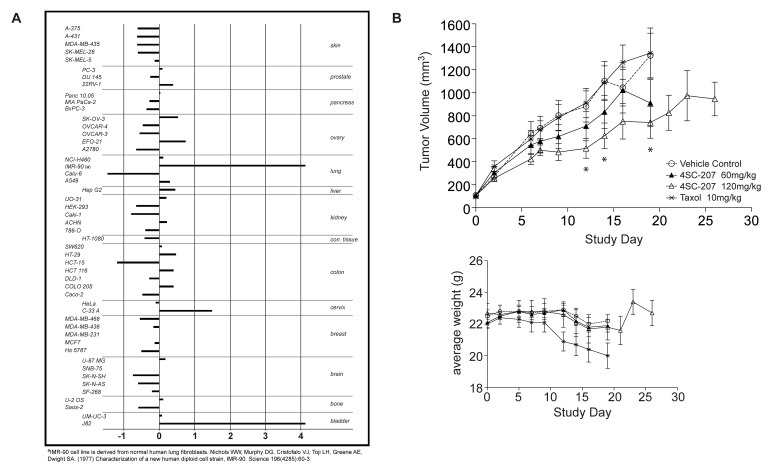
4SC-207 inhibits proliferation with an average GI50 of 11nM and promotes tumor growth reduction in
vivo.(A) 4SC-207 was tested on a panel of 50 tumor cell lines from 14 different tissues and the GI50 values are represented as Z-scores, i.e. deviation of actual GI50 from the average GI50 divided by the standard deviation (SD). Negative Z-scores indicate higher sensitivity, positive Z-scores less sensitivity of cell lines towards the compound with respect to the mean GI50. The x-axis is displayed in log scale. (B) Female SCID mice bearing a HCT-15 colon cancer xenograft were treated with indicated concentrations of 4SC-207 (▲ and Δ), Taxol® (×) and control (○). Treatment was started at an average tumor volume of 100mm3 (Day 0) and continued for 3 weeks (treatment of 4SC-207 at 120mg/kg was extended for an additional week). Tumor volume and body weight were measured three times a week (see also Table 3). Significant reduction of tumor volume, indicated by * (two-tailed Mann-Whitney U-test; significance level p<0.05), was observed for treatment Group 3 (120mg/kg 4SC-207) on Day 12 (p=0.048), Day 14 (p=0.031) and Day 19 (p=0.025).